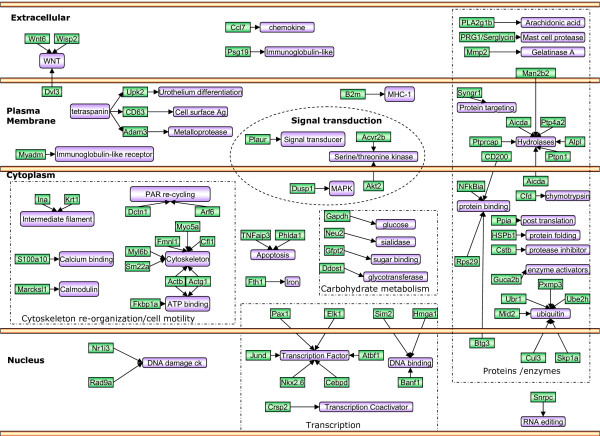
A. PAR1-dependent genes. Inflammation was induced by intravesical instillation of substance P or LPS into the bladder of WT and PAR1-/- mice and compared to control (saline-treated); see methods for details. Twenty-four hours after, bladders were removed and the RNA was isolated for cDNA array experiments. Genes that were upregulated in response to inflammation in wild type mice and failed to be up-regulated in PAR1-/- mice were considered to be PAR-1 dependent transcripts. PAR-1 dependent transcripts were used to query the Ingenuity Pathways Analysis [IPA] and based on EntrezGene and Gene Ontology annotations were distributed into relevant biological compartments and biological interactions.